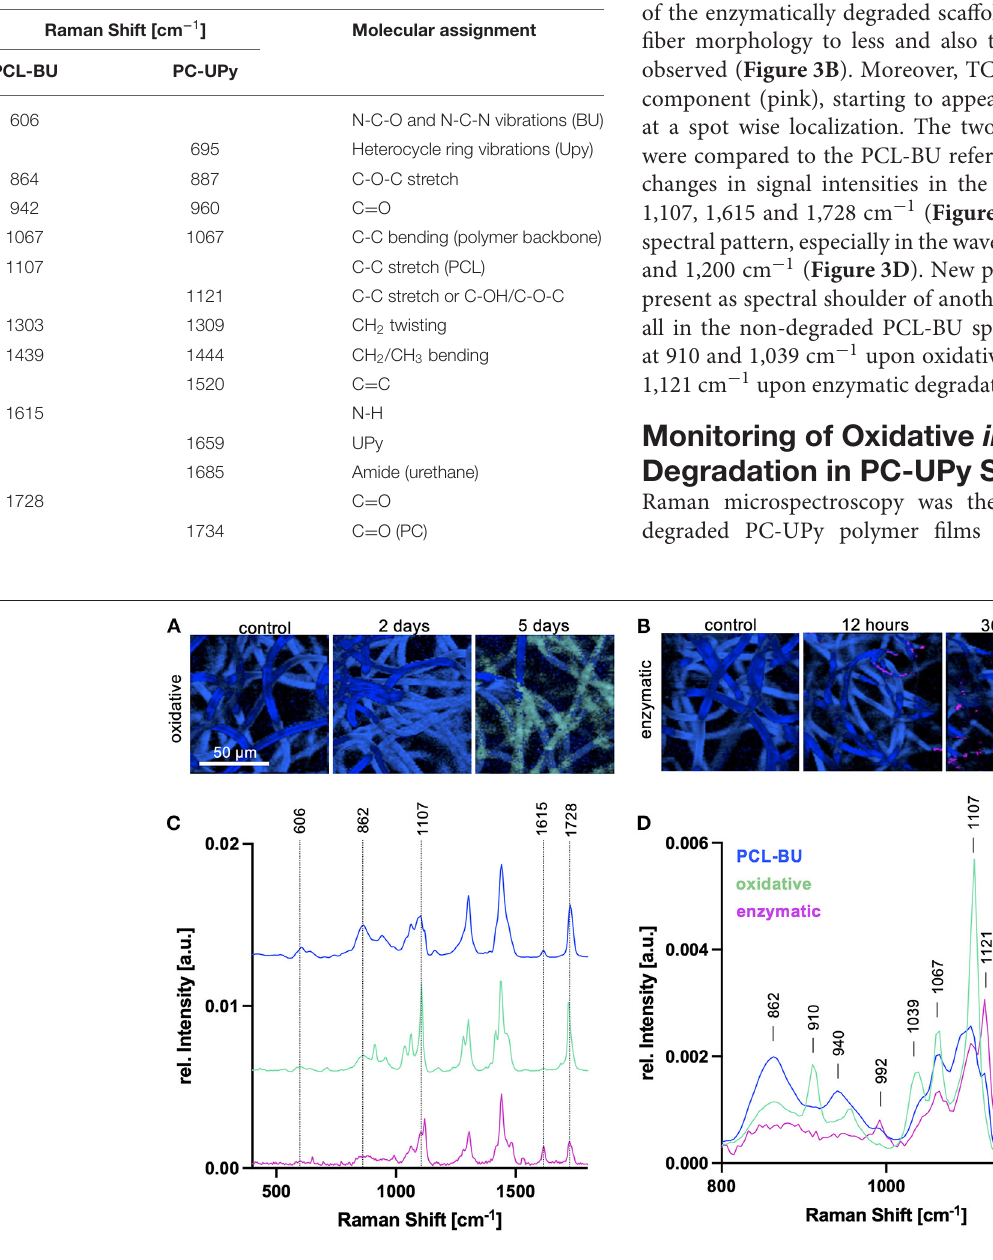
FIGURE 3 | Oxidative and enzymatic degradation in PCL-BU scaffolds. (A) TCA heatmaps of electrospun PCL-BU scaffolds at 0, 2 and 5 days of oxidative degradation. Scale bar equals 50 µ m (B) TCA heatmaps of electrospun PCL-BU scaffolds at 0, 12 and 36h of enzymatic degradation. (C) Average Raman spectra identified by TCA. blue—PCL-BU; light green—signature in 5d oxidatively degraded PCL-BU fibers; pink—signature appearing after 12h of enzymatically degraded PCL-BU fibers. Labeled peaks correspond to bands with changes in peak intensity. (D) Zoom into the 800–1,200 cm − 1 Raman shift range.